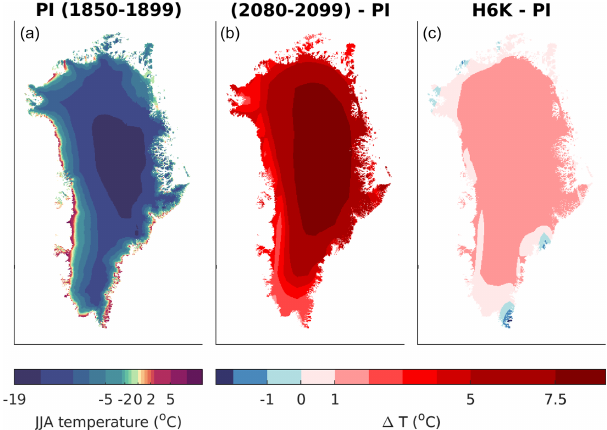
Figure 11. Mean summer 2m temperature of the PI period (years 1850 to 1899) in the experiment Industrial (a) and anomalies of summer mean 2m temperature with respect to PI of the Industrial experiment 2080 to 2099 period (b) and mean mid-Holocene (H6K) summer 2m temperatures (c)